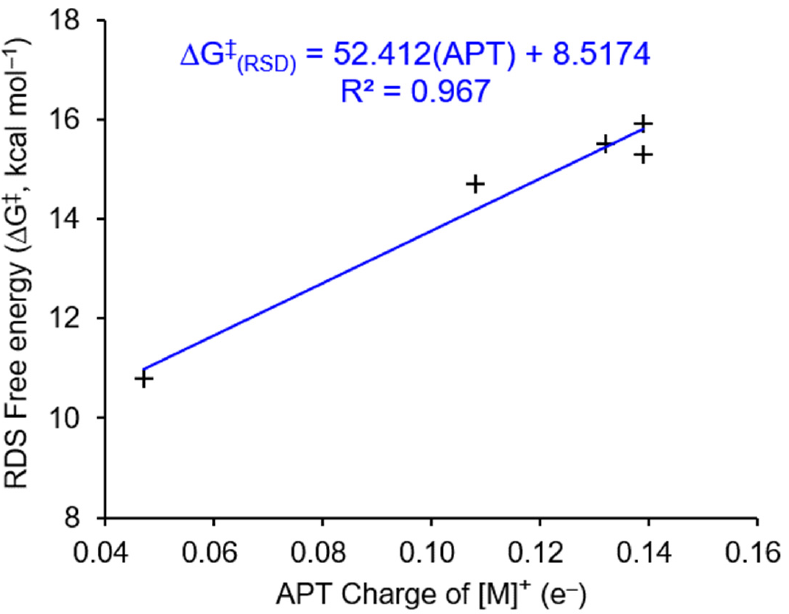
Figure 6. The linear fitting between the ∆ G ‡ of RDS for Ni–H complexes I to V and the APT charges of Ni atoms in the related [Ni] + .